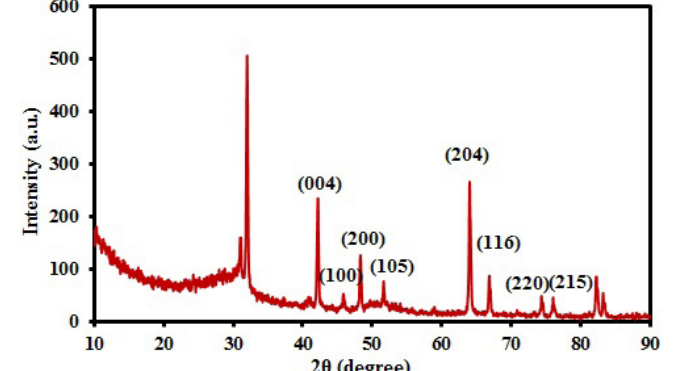
Fig. 5. XRD pattern of the RGO/TiO